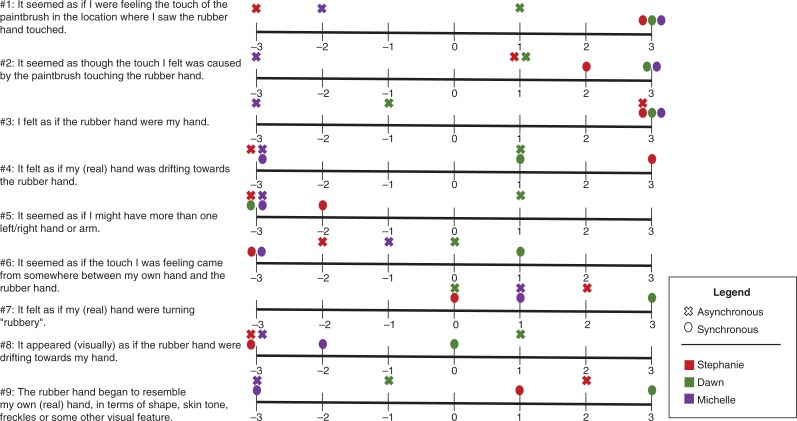
Answers from all three case report subjects to the nine-question post-trial questionnaire administered following each asynchronous and synchronous trial. Each question is evaluated on a Likert scale spanning from – 3 (complete disagreement) and+3 (complete agreement). The first three questions assess the illusion effect, whereas the last six serve as control questions. This plot reveals that all subjects endorsed the subjective perception of the illusion following the synchronous trial, whereas only Stephanie endorsed the perception of the illusion following the asynchronous trial. It is important to note that for both Stephanie and Dawn, the asynchronous trial was performed first and the synchronous trial second, whereas for Michelle, the order was reversed.